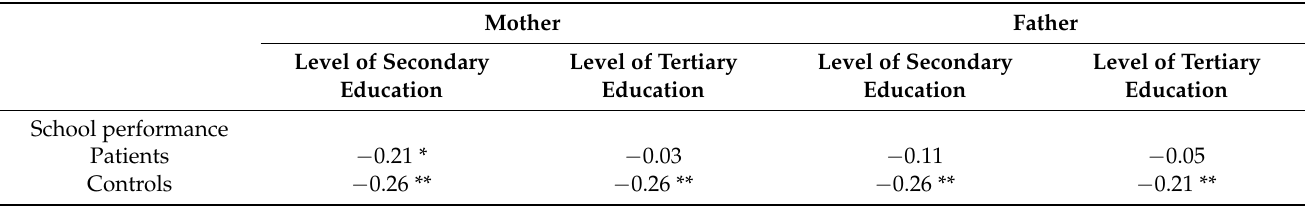
Table 6. Correlation of school performance and parental formal education background–Pearson’s rho correlation coefficient. School marks range from 1: very good to 6: very poor, i.e., lower numbers signify better performance. Mother Father Level of Secondary Level of Tertiary Level of Secondary Level of Tertiary Education Education Education Education School